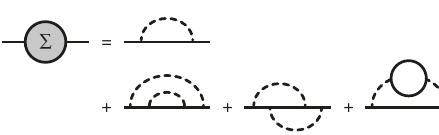
Fig. 1 Next-to-leading-order self-energy diagrams. Diagrams for the e -ph self-energy up to O ( g 4 ), where g is the e – ph coupling constant. The fi rst two diagrams in the second row contribute to the two-phonon scattering